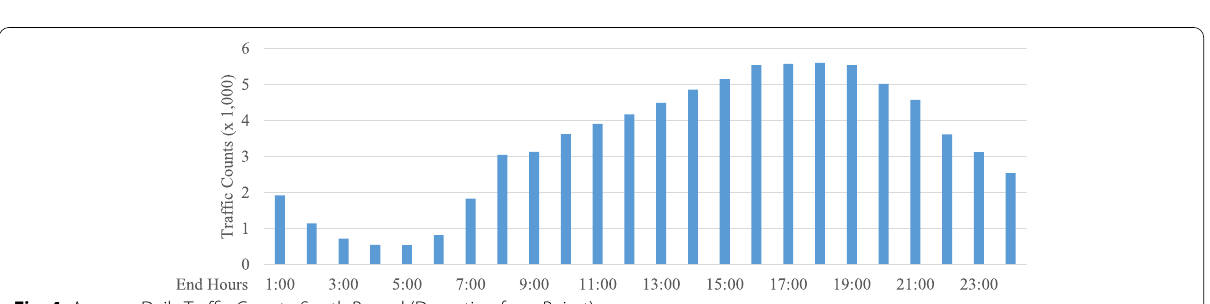
Fig. 4 Average Daily Traffic Count ‑ South Bound (Departing from